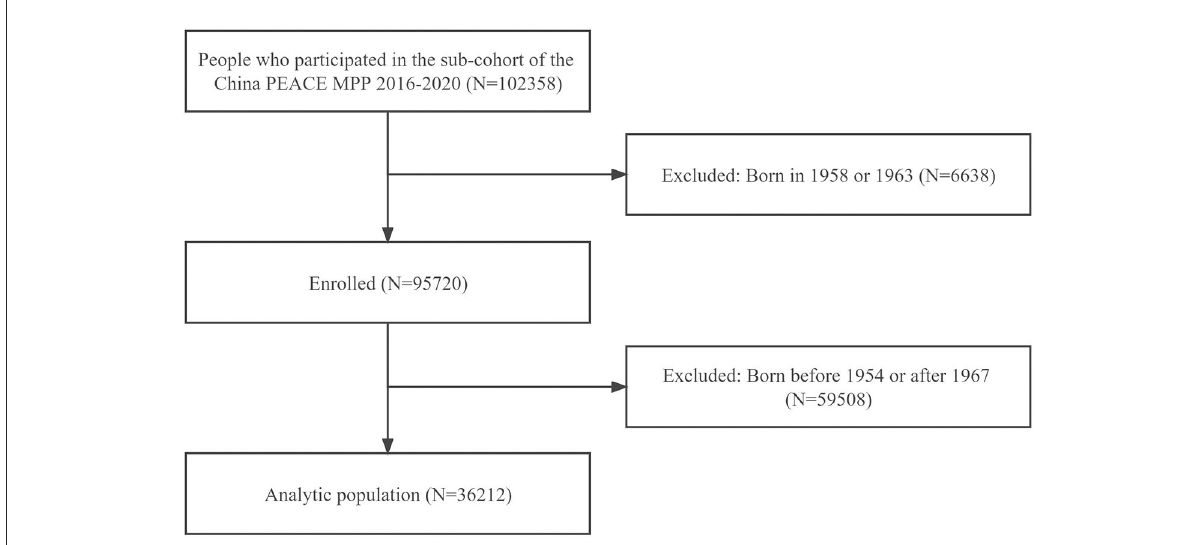
FIGURE1 Flow chart of study participants. PEACE MPP, Patient-Centered Evaluative Assessment of Cardiac Events Million Persons